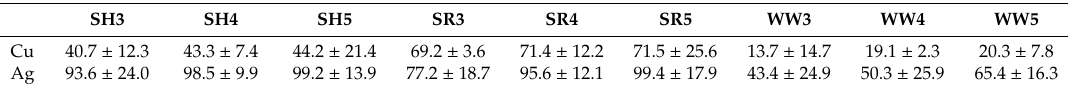
Table 7. Biochar e ffi ciency (%) with standard deviations ( n = 3) for 300 mg / L: SH3 (sunflower